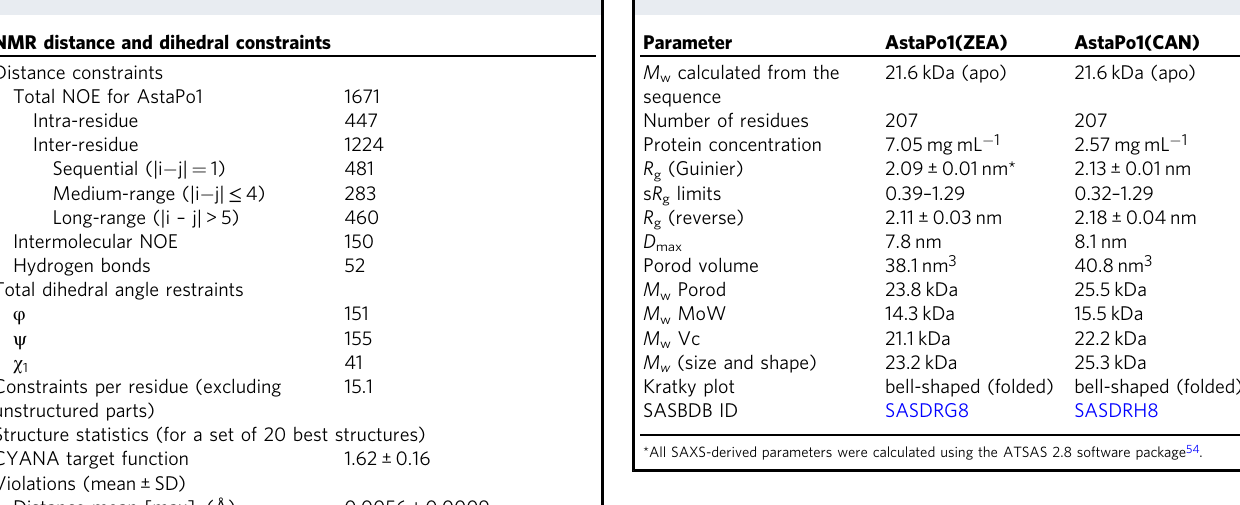
Table 1 NMR input data and statistics for the AstaPo1(AXT) complex.